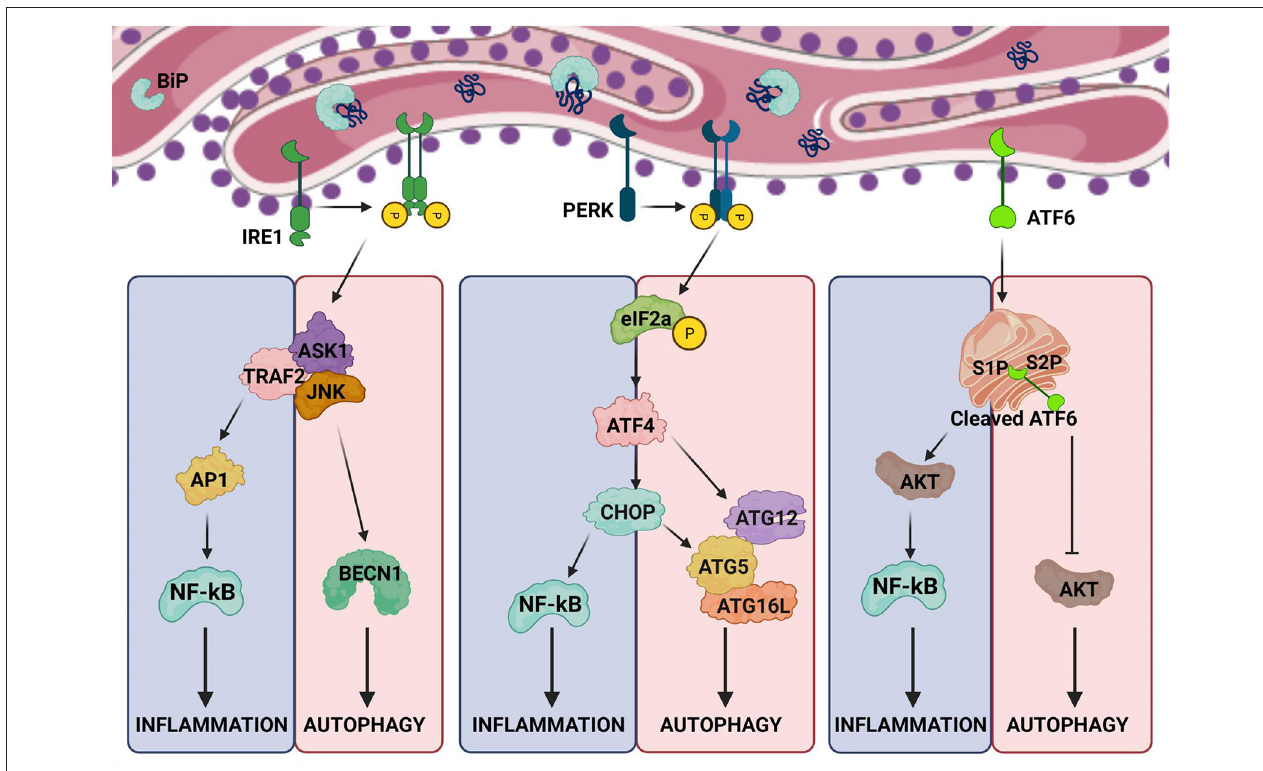
FIGURE 2 | Crosstalk between ER stress, autophagy and inflammation. The arms of UPR activating inflammation also intersect with pathways regulating autophagy. The possible points of intersection are shown in the